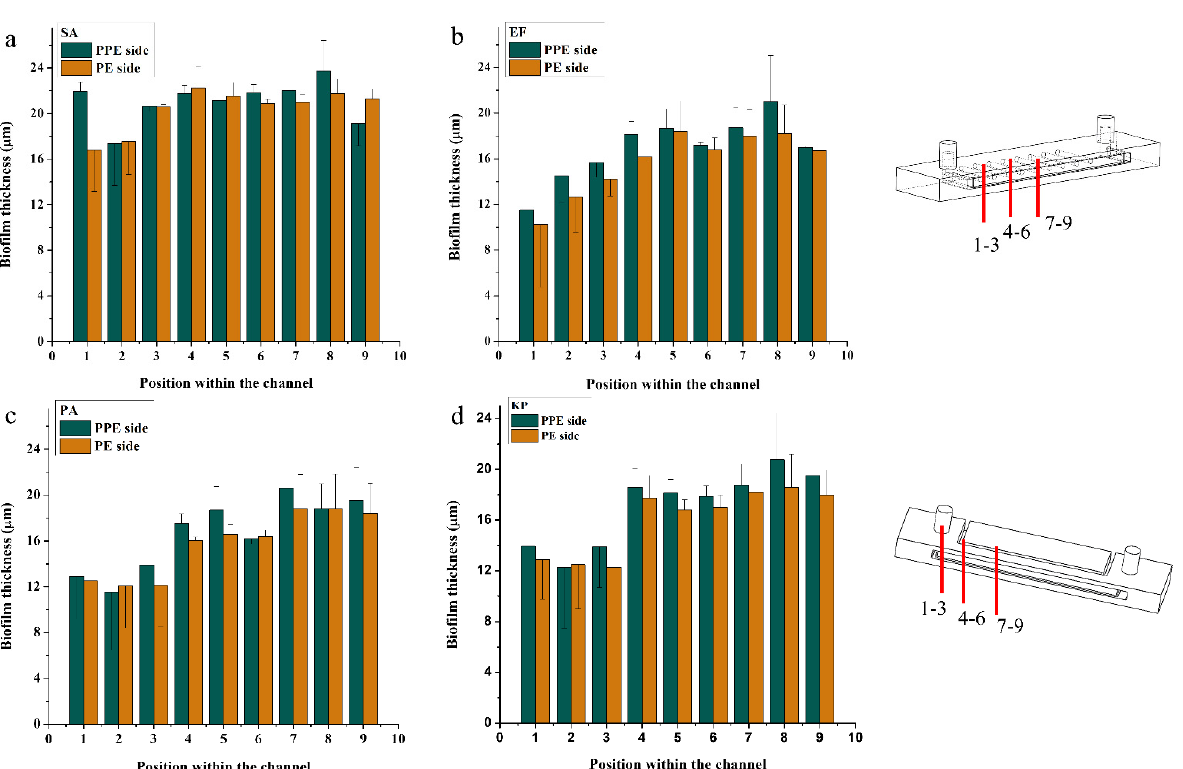
Figure 8. The evolution of the biofilm thickness within PPE and PE sides of the channels at different distances from the inlet (1–3 inlet area, 4–6 middle of the channel, 7–9 end side of the channel) for: ( a ) SA, ( b ) EF, ( c ) PA, and ( d ) KP biofilms.